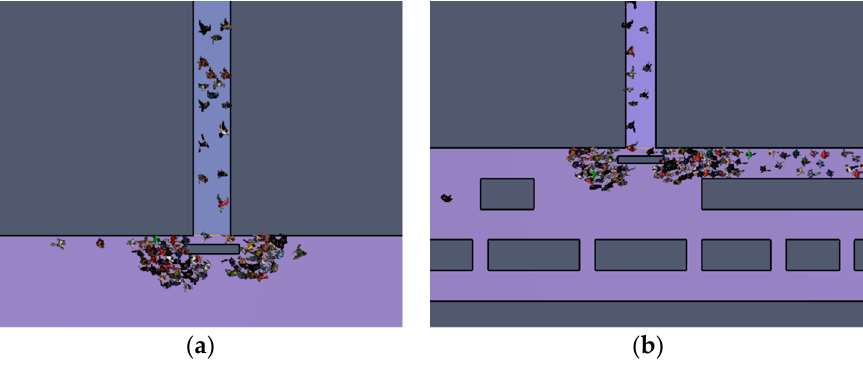
Figure 20. Situations of the transverse passage entrance: ( a ) moderate congestion; ( b ) heavy congestion.